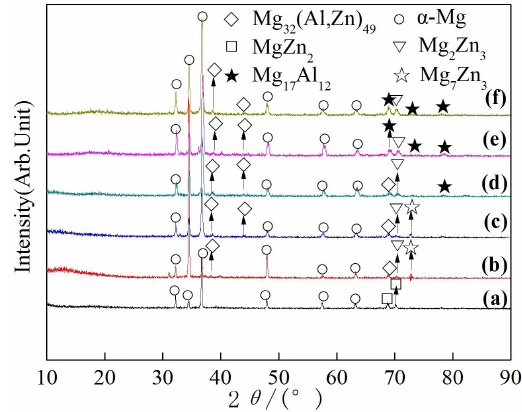
Figure 2 - XRD patterns of the as-cast alloys: (a) ZA120 alloy; (b) ZA122 alloy; (c) ZA124 alloy; (d) ZA126 alloy; (e) ZA128 alloy; (f) ZA1210